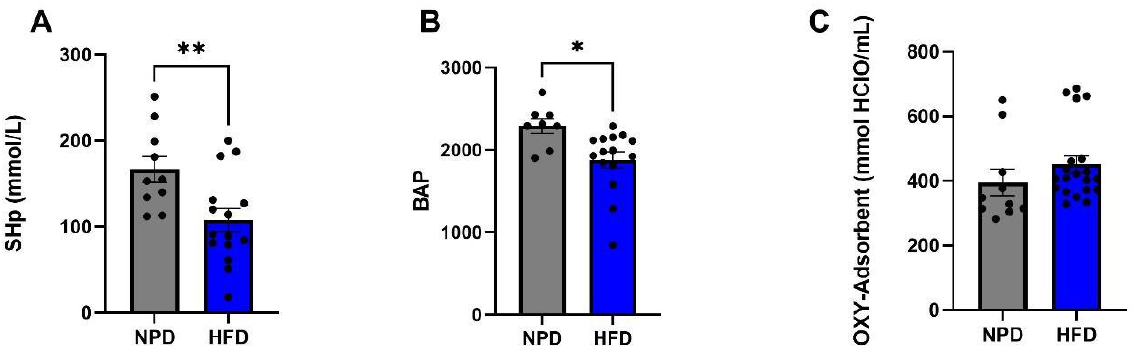
in HFD compared to NPD group (respectively: t = 2.28, df = 28, p = 0.0321 and t = 2.41, df = 28, p = 0.022, as in Figure 6A,B).